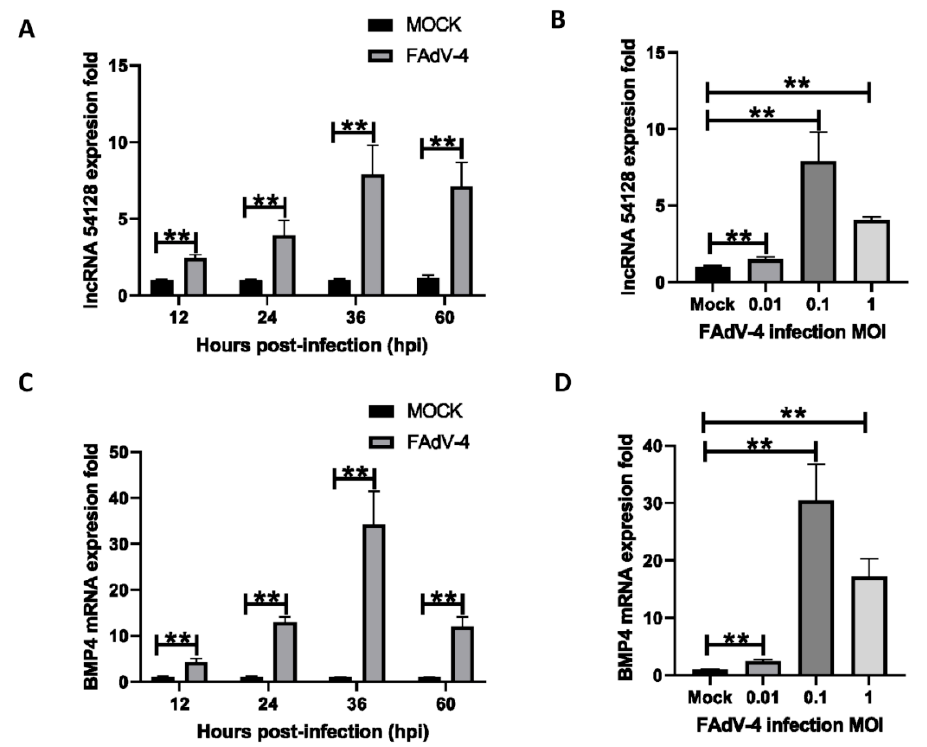
Figure 5. LncRNA 54218 and BMP4 upregulation over the course of FAdV-4 infection. ( A , C ) LMH cells were infected with FAdV-4 (MOI = 0.1) for 12, 24, 36 and 60 h, and the transcription levels of LncRNA 54218 and BMP4 were determined by qPCR. ( B , D ) LMH cells were infected with FAdV-4 (MOI = 0.01, 0.1, 1) for 36 h, and the transcription levels of LncRNA 54218 and BMP4 were determined by qPCR. The data represent the mean ± SD of three independent experiments. p values were calculated using Student’s t test. An asterisk indicates a comparison with the indicated control. ** p < 0.01, n.s., not